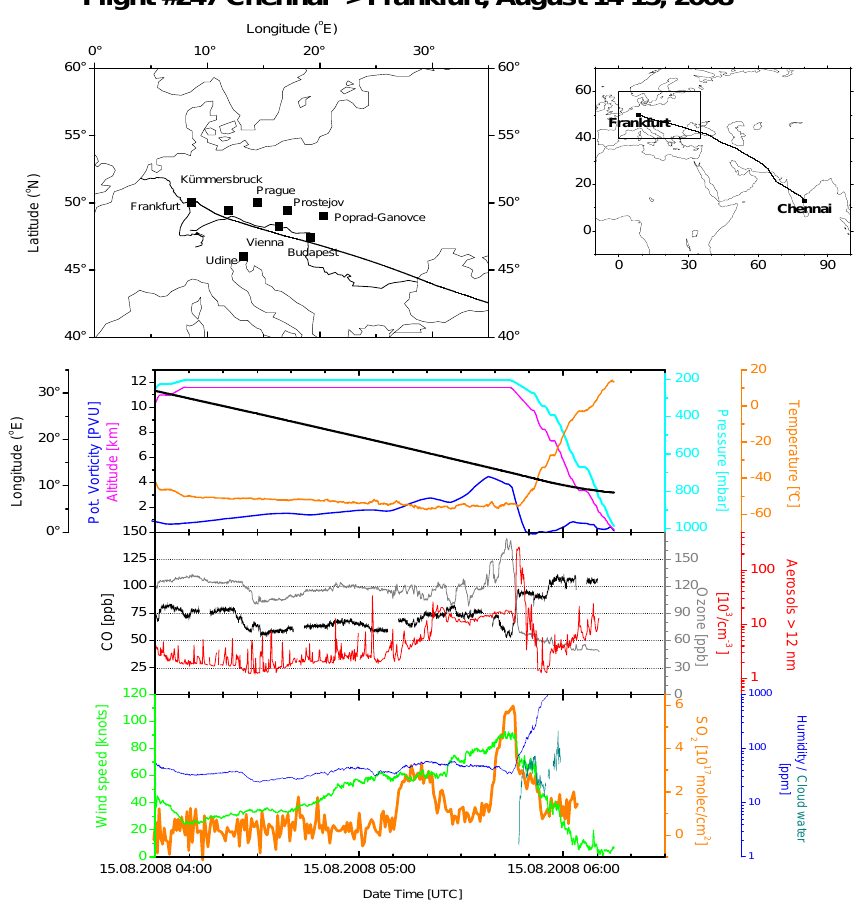
Fig. 7. Overview of the CARIBIC flight track and selected measurements from 04:00 to 06:30UTC 15 August 2008. Along the flight track some sounding stations are depicted. The second panel gives measured flight information, and PV (model based). Both SO 2 peaks (bottom) occur at PV ≥ 2. The rapid decline in the SO 2 SCD (second peak) coincides exactly with an increase in cloud water and